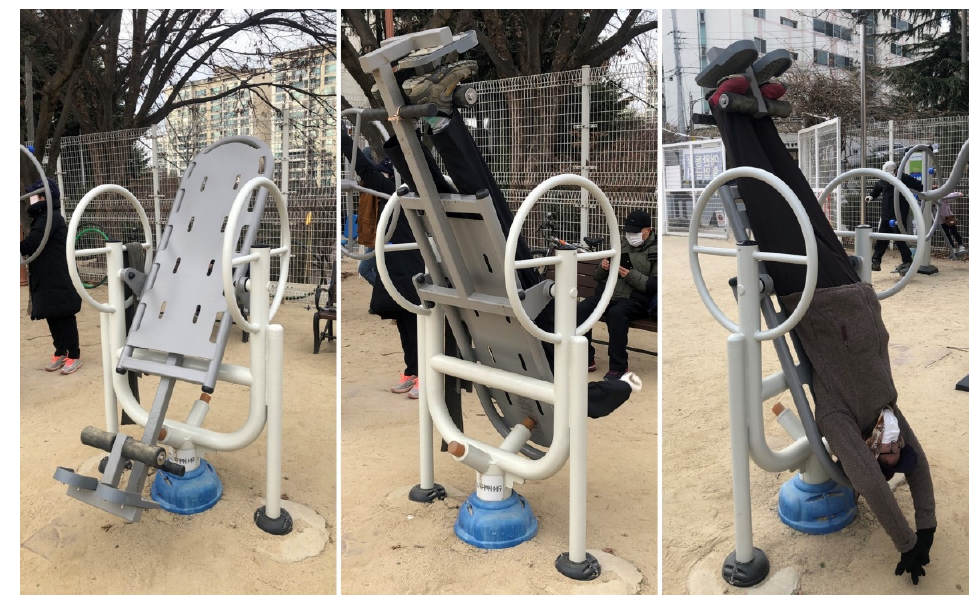
Figure 2. The user lies on the inversion table and invert oneself vertically.